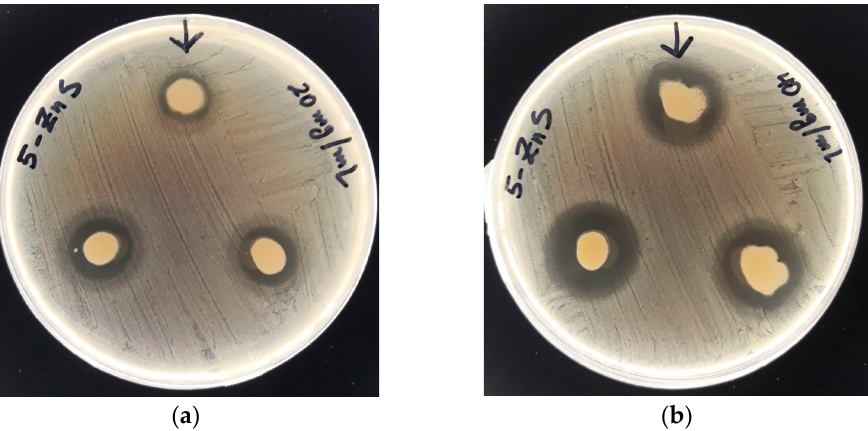
Figure 8. Inhibition zone for Staphylococcus aureus strain in the presence of ZnS nanoparticles at two concentrations ( a ) 20 mg/mL and ( b ) 40 mg/mL.